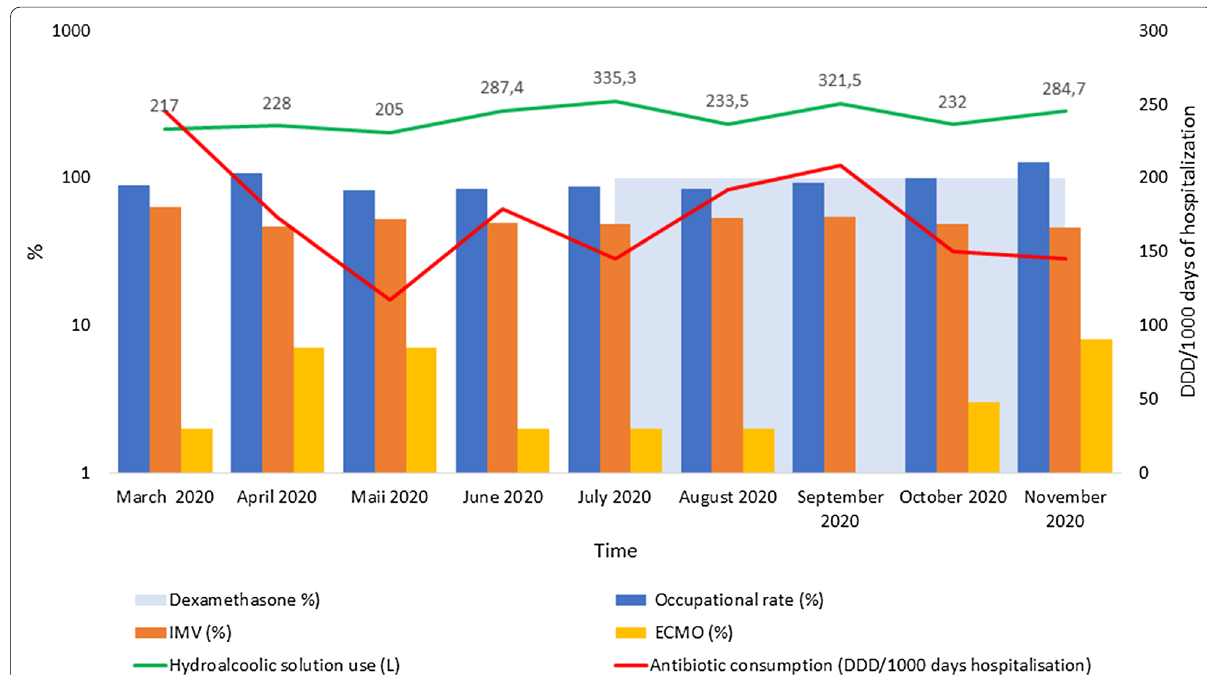
Fig. 3 Constructing timelines showing the occupational rate, invasive MV and ECMO rates, hydroalcoholic solution consumption, antibiotic (piperacillin–tazobactam) consumption and dexamethasone across the study period. DDD daily defined dose, ECMO extracorporeal membrane oxygenation, IMV invasive mechanical